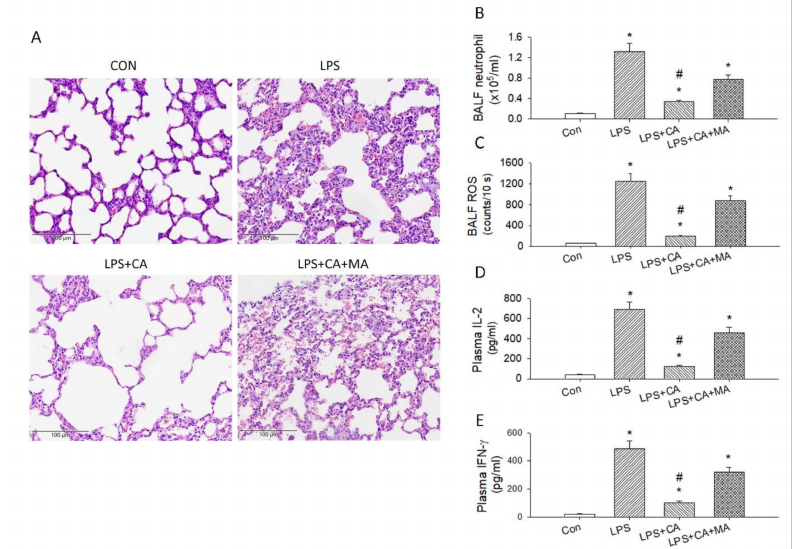
Figure 8. Catechins treatment reduced LPS-induced ALI. ( A ) H&E staining of the lung in the four groups of mice. ( B ) Analysis of neutrophils in the BALF of four groups ( n = 6). ( C ) The ROS amount in the BALF of these four groups ( n = 6). The concentration of plasma IL-2 ( D ) and IFN- γ ( E ) of these four groups ( n = 6); * p < 0.05 vs. Con. # p < 0.05 vs. LPS.